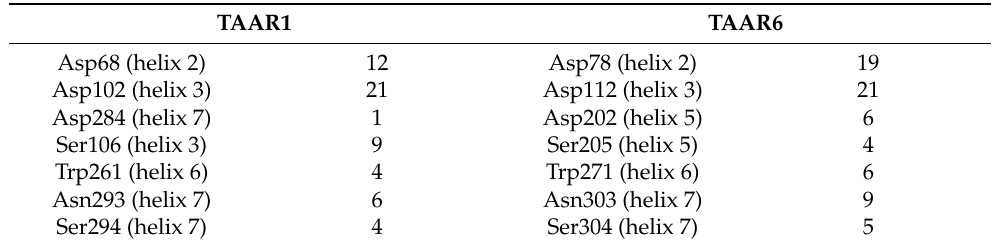
Table 5. Frequencies of formation (in%) of hydrogen bonds by various amino acid residues for the TAAR1 and TAAR6